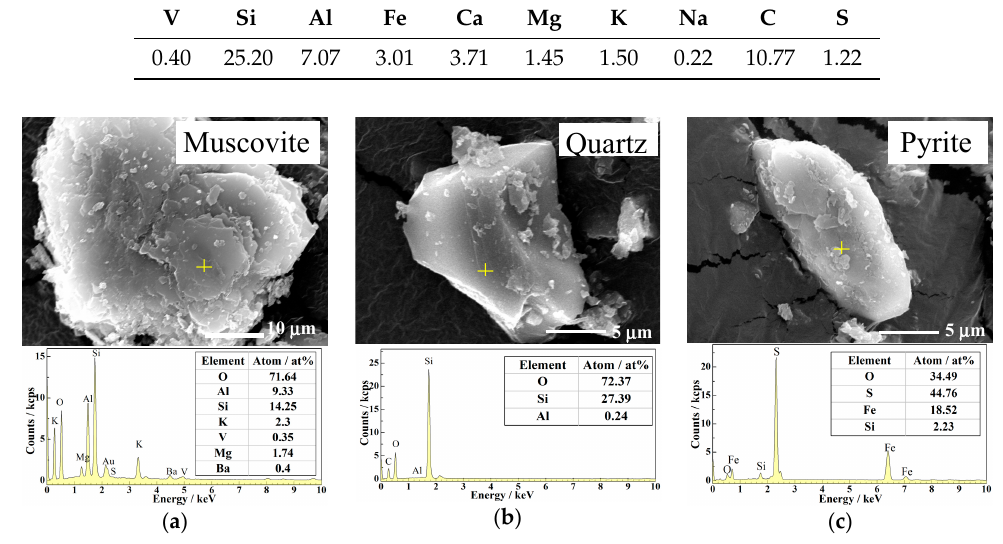
Table 1. Main chemical composition of the black shale (wt %).